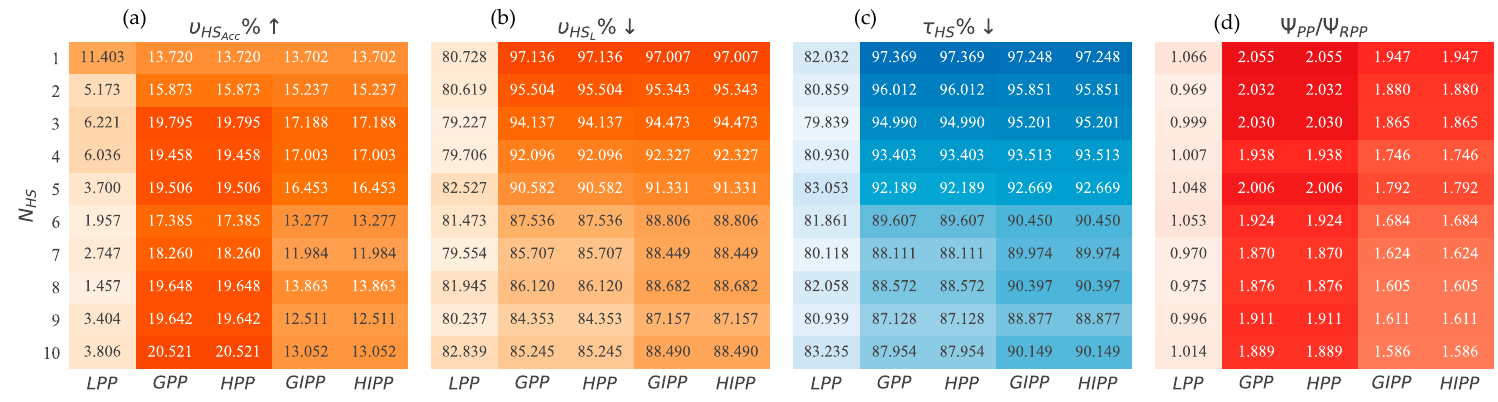
; ( b ) Percentage reduction ACC